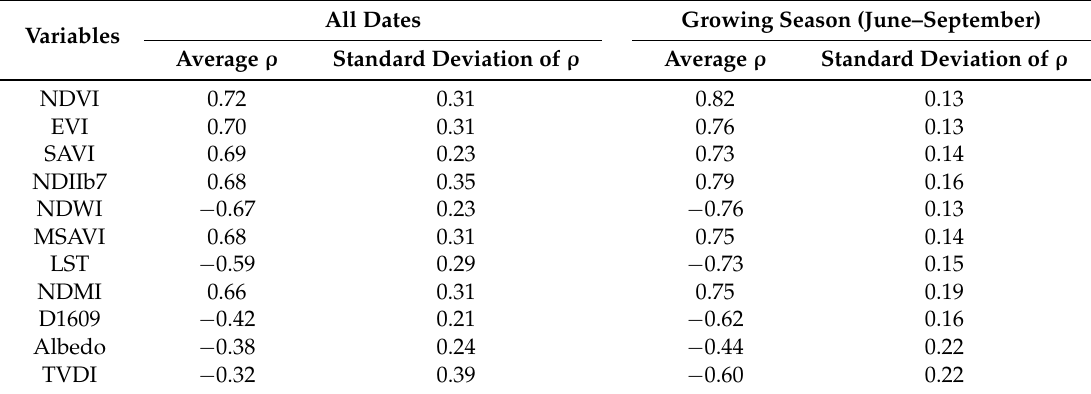
Figure 5. Importance of the 11 variables represented by the average increase in Mean Squared Error (MSE) of evapotranspiration (ET) resulted from all RF models at the four sites. Table 5. Correlation coefficients between Landsat variables and MODIS ET.